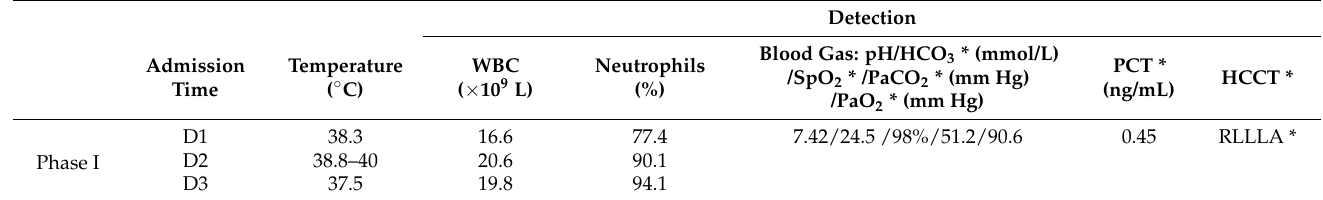
Table 1. Clinical data of the